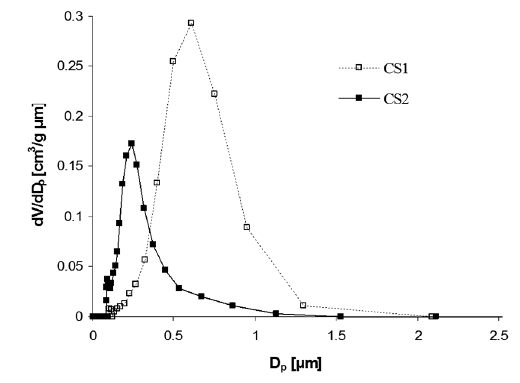
Figure 3: Pore size distribution of CS1 and CS2 calcium sulfate cements. pore size of the CS1 sample are about three times larger to those of CS2 sample. In addition the porosity is much higher for CS1 sample (43%) as compared with CS2 (20%) (see also Table 2). These structural changes could be explained in terms of recipe differences such as sintering temperature or sintering program 19 . On the other hand, low-pressure measurements (extending to pore sizes up to 180 μ m) of both samples did not reveal any significant structural changes. Similar results have also been observed in a series of cements containing CSD crystals and TiHA particles 20 . In addition, a bimodal pore size distribution has been deduced because of the void formation between CSD plate-like crystals and the cavity existence between TiHA grain aggregates. In the case of the pristine CSD crystal, however, a single pore size distribution ( D ) has been observed and the structural p characteristics of that sample ( ε =37%, D =0.55 μ m) are very p close to CS1 (Table 2). Table 2: Characteristic properties obtained from mercury porosimetry measurements; ε is the porosity.